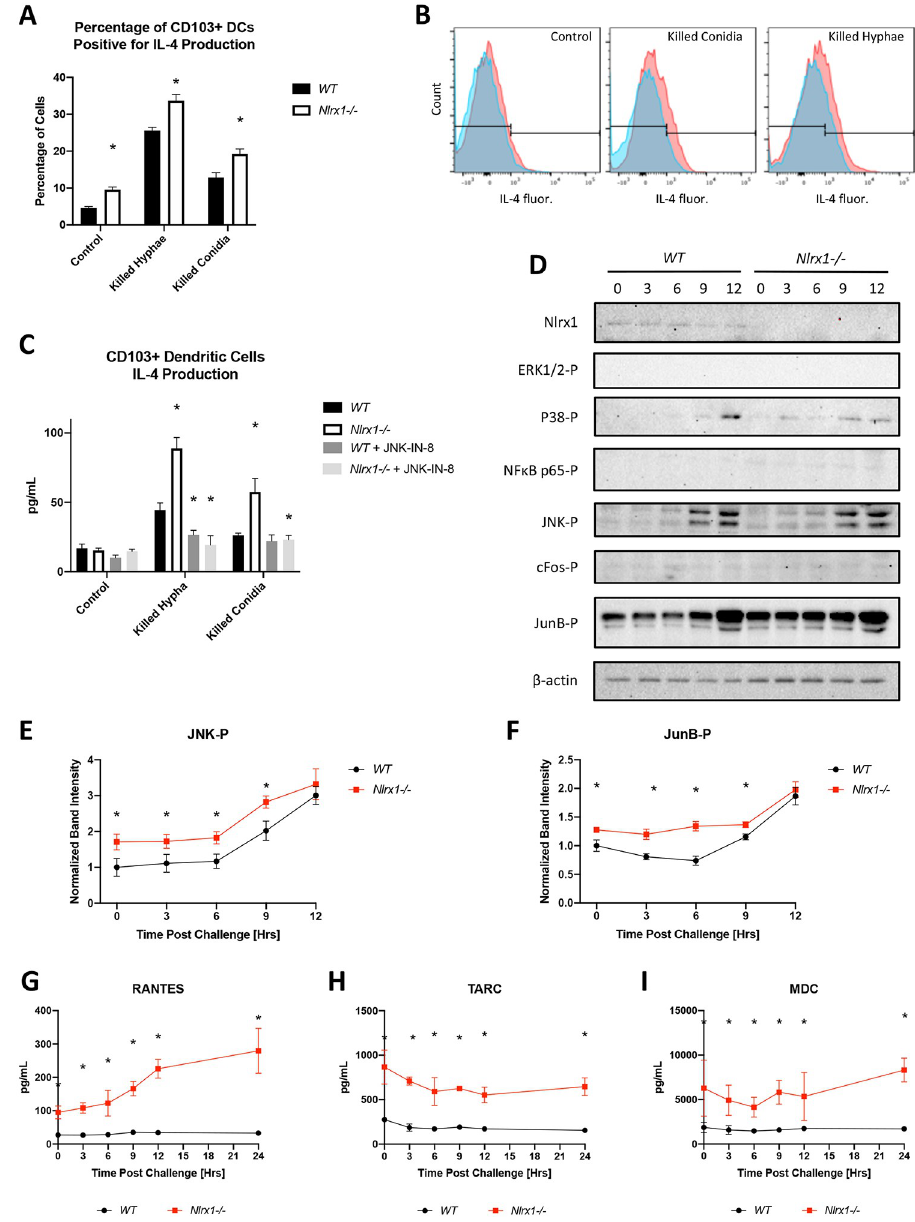
Fig 6. Temporal immune responses by CD103+ DCs during in vitro fungal challenge assays. Freshly harvested AF293 conidia (5 X 10 5 ) were challenged against wild type and Nlrx1-/- CD103+ DCs (5 X 10 5 ) at 37˚C at 5% CO 2 . Supernatant and cells were harvested immediately prior to challenge (0 hrs), and at 3, 6, 9, 12 hrs post challenge. (A) Percentage of wild type and Nlrx1-/- CD103+ DCs staining positive for IL-4 12 hours post treatment with killed hyphae and conidia. (B) Representative histograms and gating for IL-4 fluorescence. See S2 Fig for strategy. (C) Intracellular measurement of IL-4 by wild type and Nlrx1-/- CD103+ dendritic cells 12 hours post treatment with killed hyphae and conidia in the presence and absence of the JNK inhibitor (JNK-IN-8). (D) Western blot analysis of phosphorylated (-P) ERK1/2-P, P38-P, NF κ B p65-P, JNK-P, cFos-P, JunB-P, Nlrx1, and β -actin from wild type and Nlrx1-/- CD103+ dendritic cells during a 12-hour challenge against viable A . fumigatus conidia. Quantification of (E) JNK-P and (F) JunB-P. Measurement of secreted (G) RANTES (CCL5), (H) TARC (CCL17), (I) MDC (CCL22) by wild type and Nlrx1-/- CD103+ dendritic cells during a 24-hour challenge against viable A . fumigatus conidia. Asterisk denotes statistical significance, P < 0.05 Mann-Whitney U test. Error bars indicate standard deviation. N = 6–8 per experimental